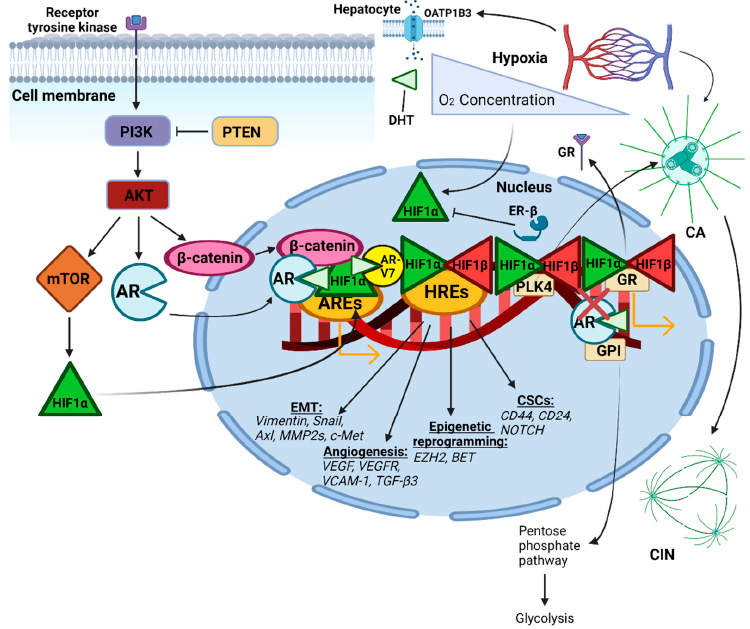
Figure 1 . Illustration of the potential role of hypoxia in mediating resistance to AR therapy in TNBC. Adaptation of AR-positive TNBC cells to hypoxic conditions may be interfering with the efficacy of current AR-targeted therapeutics via (i) downregulating ER- β to upregulate HIF-1 α transcription, (ii) upregulating compensatory pathways that enhance HIF-1 α transcriptional activity, such as GR, Wnt/ β -catenin, and PI3K/AKT/mTOR signaling, (iii) restoration of AR-repressed GPI, (iv) upregu- lation of steroid hormone receptors such as OATP1B3 upon hypoxia induction to increase hepato- cytic androgen uptake, (v) HIF-1 α -mediated induction of genes facilitating EMT, angiogenesis, ep- igenetic reprogramming, and cancer stem cell renewal, (vi) increased HIF-1 α heterodimerization with AR-V7 to alternatively upregulate AR signaling, and (vii) HIF-1 α -mediated induction of CA and subsequent CIN. Abbreviations: OATP1B3, organic anion-transporting polypeptide 1B3; DHT,